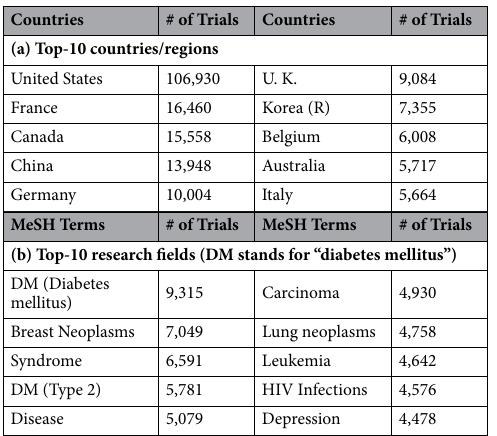
Table 1. County and research field statistics of the clinical trials used in the study.